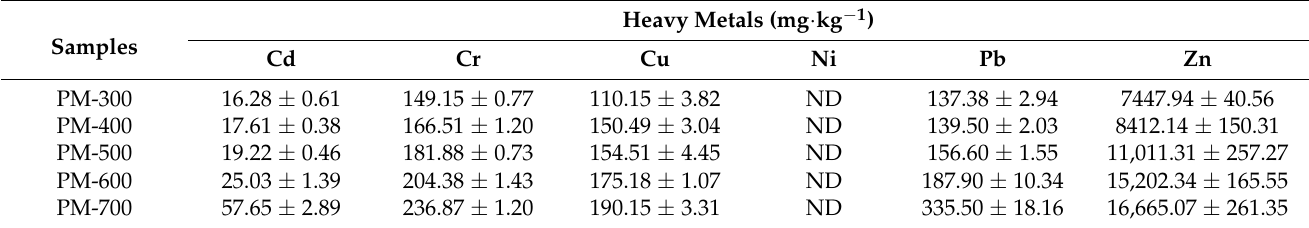
Table 5. Content of heavy metals in